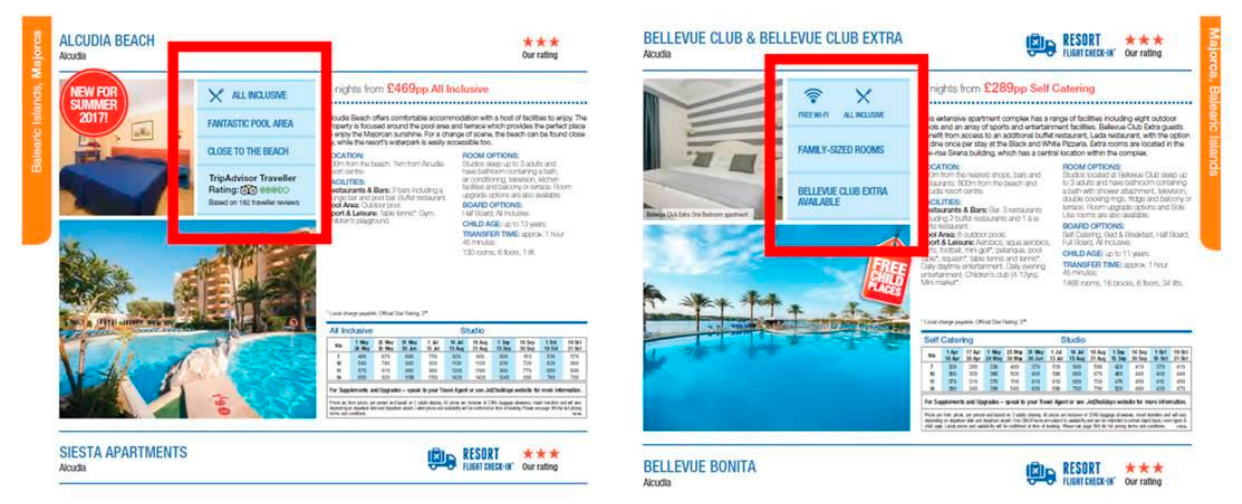
Figure A3. A specific claim to TripAdvisor reviews and performance on the website are made via an inbuilt section of the website.